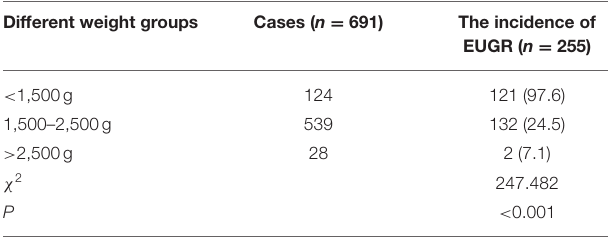
TABLE 3 | Comparison of the incidence of EUGR at discharge in 691 preterm infants with a gestational age < 34 weeks among different weight groups [ n ( %